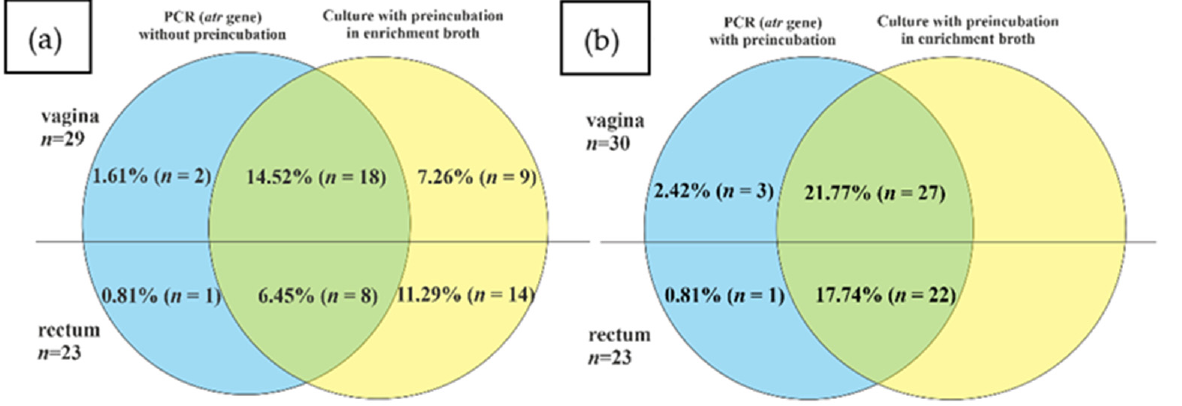
Figure 4. The comparison of GBS identification results by the culture method without preincubation in enrichment broth and by PCR method for atr gene ( a ) and with ( b ) preincubation in TH selective broth: blue, percentage/number of positive samples only in PCR; green, percentage/number of positive results both in culture method and PCR (true positive); yellow, percentage of positive results in culture method only.